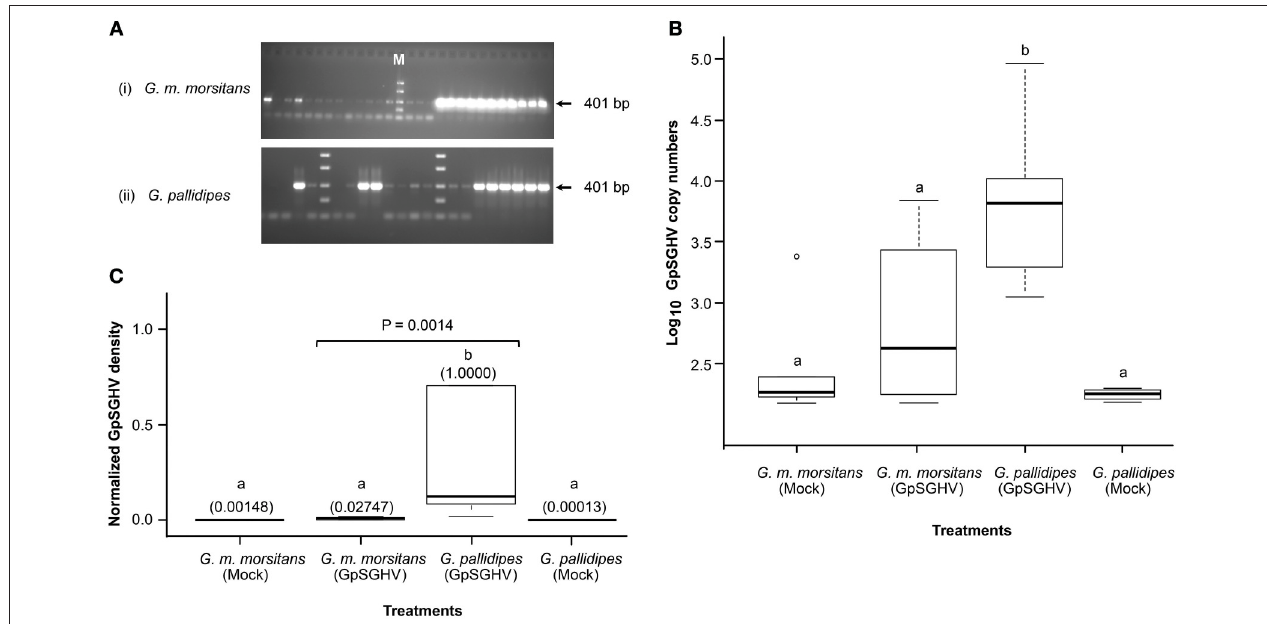
FIGURE 1 | Detection of GpSGHV infections in experimental flies. (A) Sections of agarose gels used to analyze GpSGHV infections in virus-infected G. m. morsitans (i) and G. pallidipes flies (ii) using a diagnostic PCR protocol ( Abd-Alla et al., 2007). Shown are non-infected samples (no bands), moderately-infected samples (faint bands) and highly infected samples (thick bands).M is molecular marker. The PCR amplifications were performed using genomic DNA extracted from single intermediate legs excised from 4-week old male F 1 progenies produced by the control (Mock), or virus-infected (GpSGHV) flies. Determination of the GpSGHV copy numbers and the virus density levels by qPCR are shown in (B,C) , respectively. For determination of virus copy numbers (B) , 10-fold serially diluted viral DNA (targeting odv-e66 gene) were used as internal standards as described by Abd-Alla et al., 2009a. For determination of the virus expression levels, qPCR data were normalized using a tsetse fly housekeeping gene ( β - tubulin ). Viral density levels in the virus-infected G. pallidipes progenies were significantly higher ( P = 0.0014 ) than the levels in the virus-infected G. m. morsitans flies. The values in the parentheses (C) indicate the virus density levels. Letters a and b represent significant differences between the samples (i.e., there was no significant difference between samples labeled a , while a and b were significantly